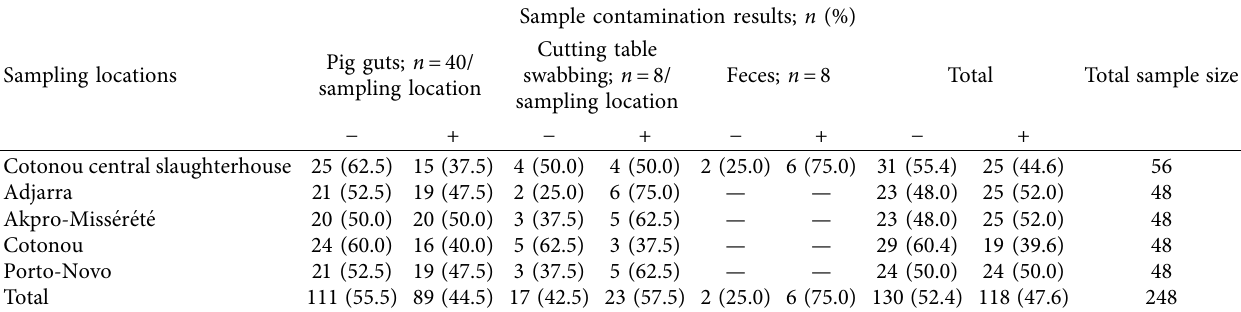
Table 2: Contamination rate of samples according to sampling locations.